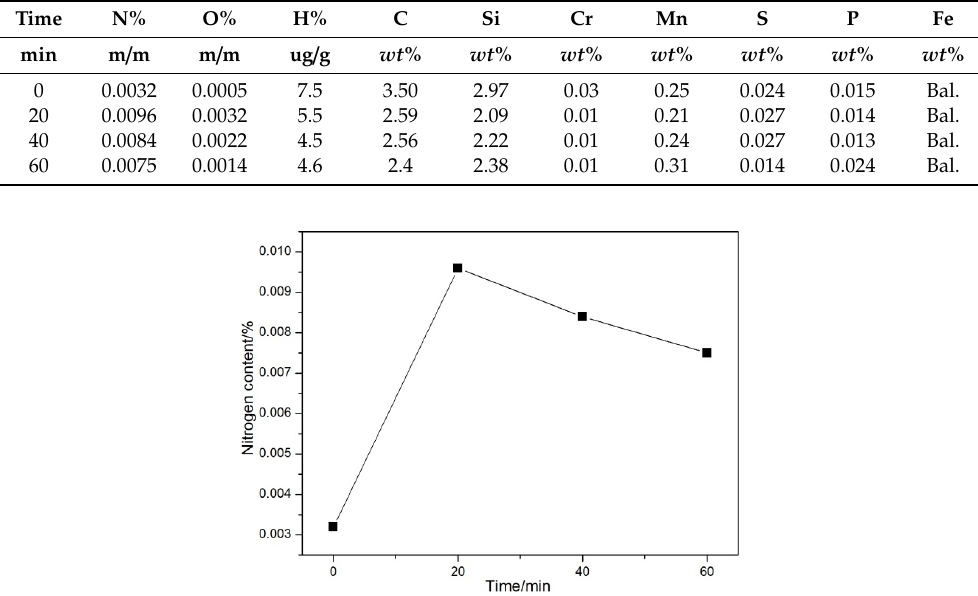
Figure 7. Content of DI after injecting nitrogen gas for different time periods.